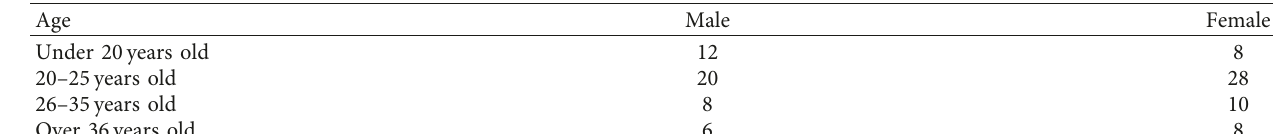
Figure 6: Model of influencing factors of online shopping. Table 2: Basic information of respondents.